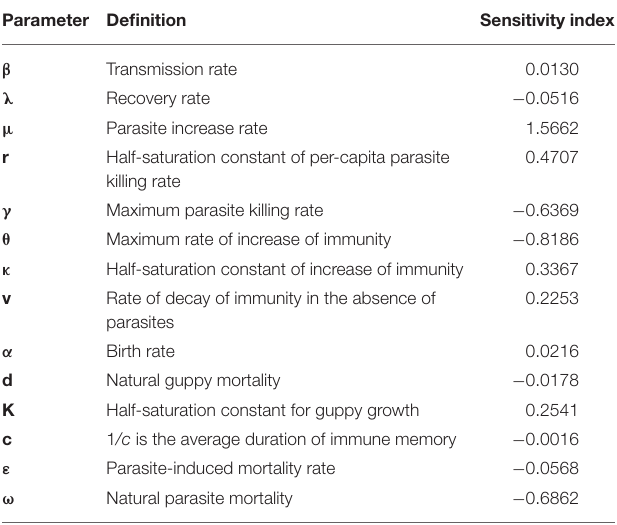
TABLE 2 | The sensitivity of the magnitude of the peak of the initial outbreak to the parameters.